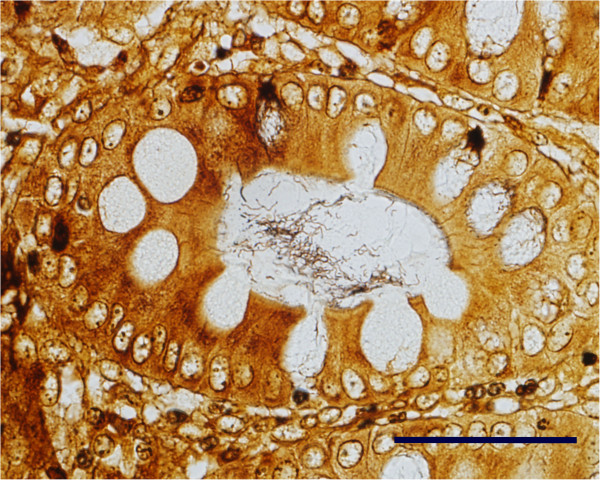
Brachyspira colitis. In the same section of proximal colon as Figure 4, the tubular mucous-secreting glands contain large numbers of long, thin spiral-shaped bacteria. Warthin-Faulkner. Bar = 100 μm.